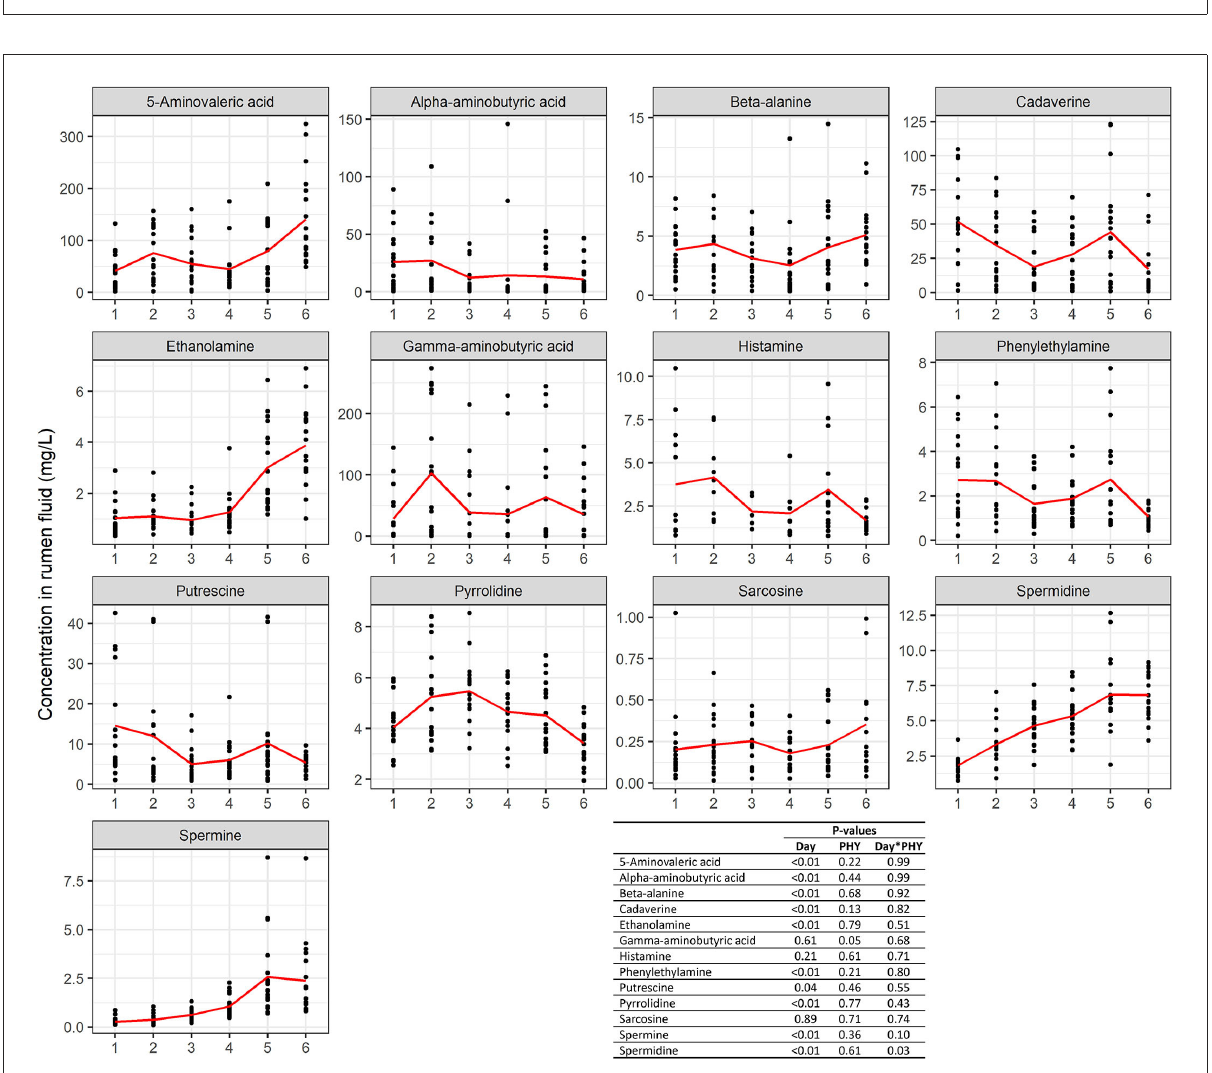
FIGURE6 Concentration of biogenic amines measured in the rumen fluid 4h after the morning feeding. The red line represents the trend of the mean values over the 6 days of experiment. P -values are presented for Day, treatment (PHY) and interaction between Day and treatment (Day *